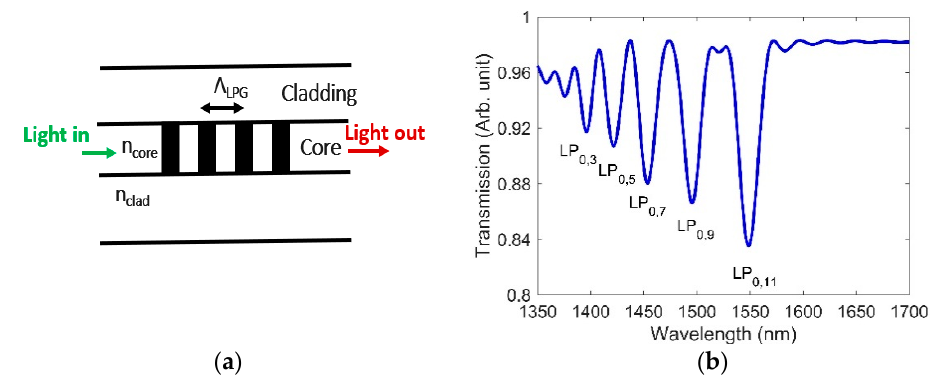
Figure 2. ( a ) LPG schematic, where 𝑛 (cid:3030)(cid:3042)(cid:3045)(cid:3032) , 𝑛 (cid:3030)(cid:3039)(cid:3028)(cid:3031) , and Λ (cid:3013)(cid:3017)(cid:3008) are the RIs of the core, cladding, and grating period, respec- tively; ( b ) transmission spectrum of the designed LPG for Λ (cid:3013)(cid:3017)(cid:3008) = 348 µm and grating strength ( ∆𝑛) = 6 × 10 (cid:2879)(cid:2872)